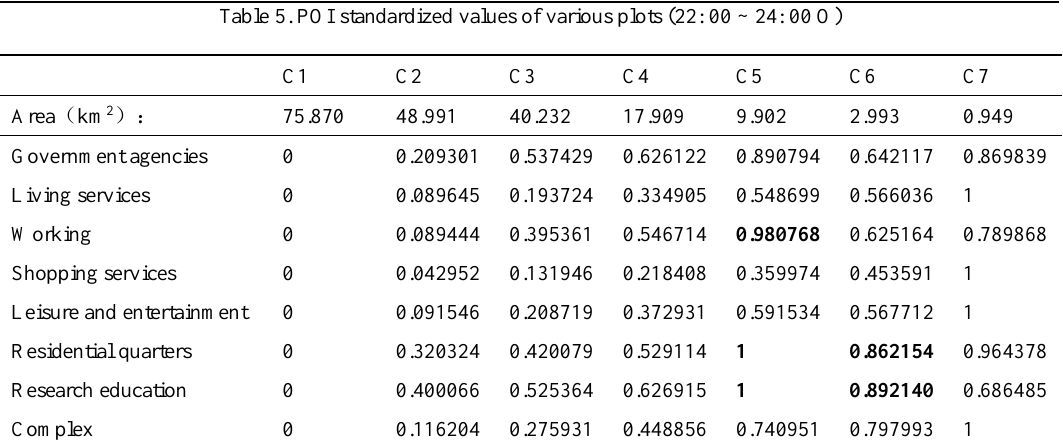
Table 6. POI standardized values of various plots (22: 00 ~ 24: 00